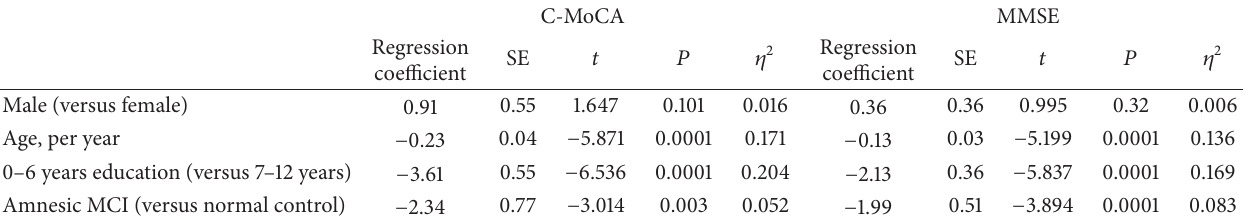
Table 3: Regression estimates of relative contributions of age, education, and aMCI diagnosis to C-MoCA